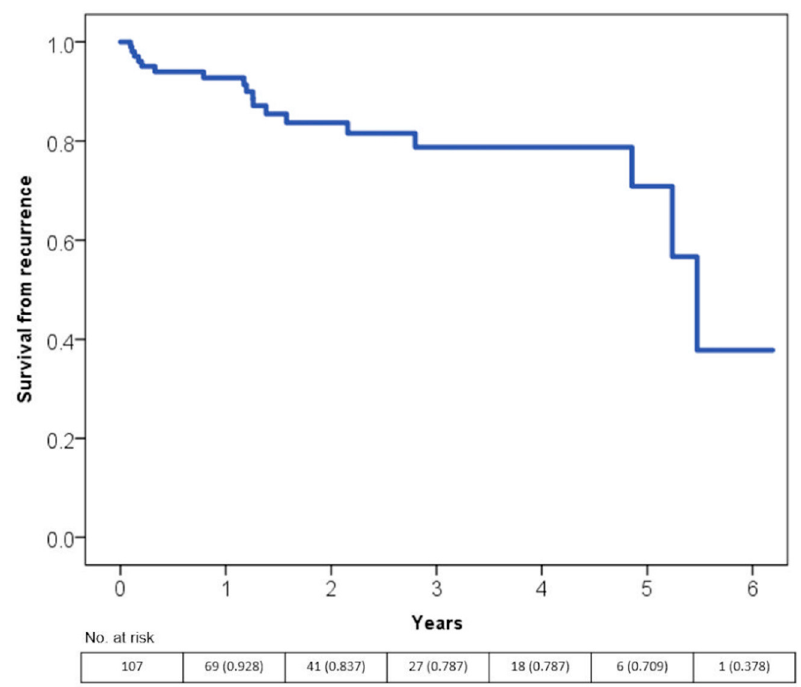
Figure 2. Time free from tachycardiomyopathy recurrence according to the Kaplan-Meier curves.